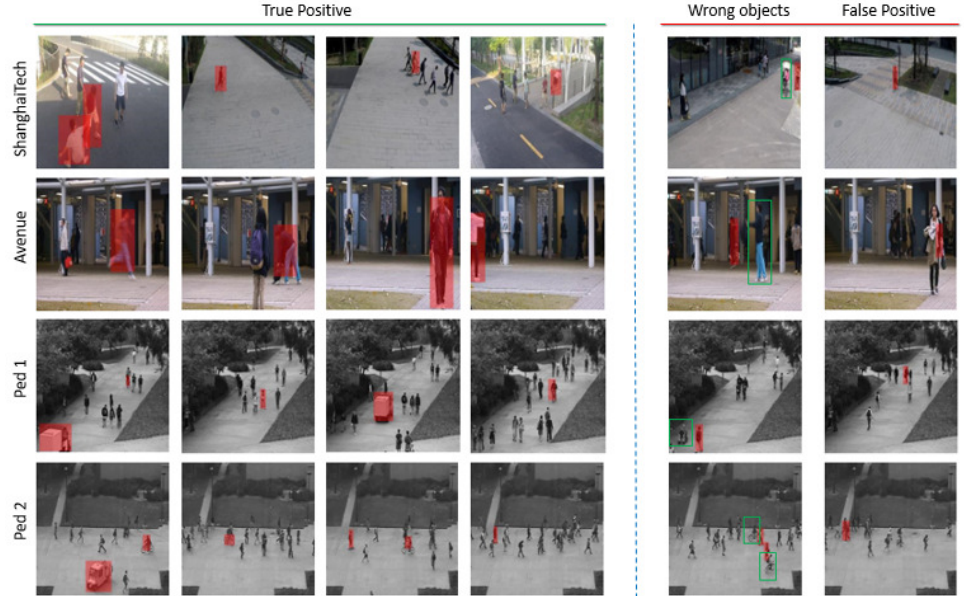
Figure 8. Qualitative results of abnormal objects localization on Avenue, Ped1, Ped2, and Shang- haiTech dataset. The left side contains correct localizations and the right side shows the failure cases with two main errors: false negative frames and detect wrong objects. The true objects are marked by green boxes. Best viewed in color.